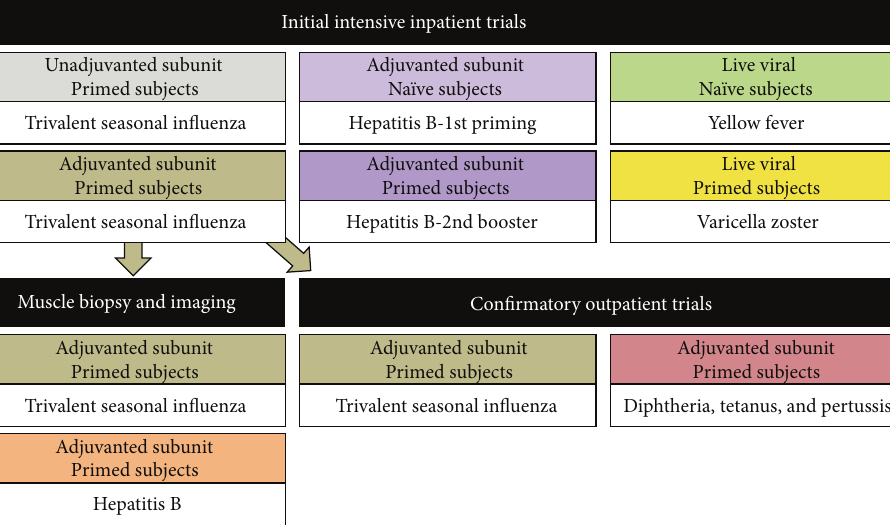
Figure 2: Organization and sequence of head-to-head comparison of adjuvanted and unadjuvanted vaccines, with live vaccines in experimental medicine studies within the BIOVACSAFE